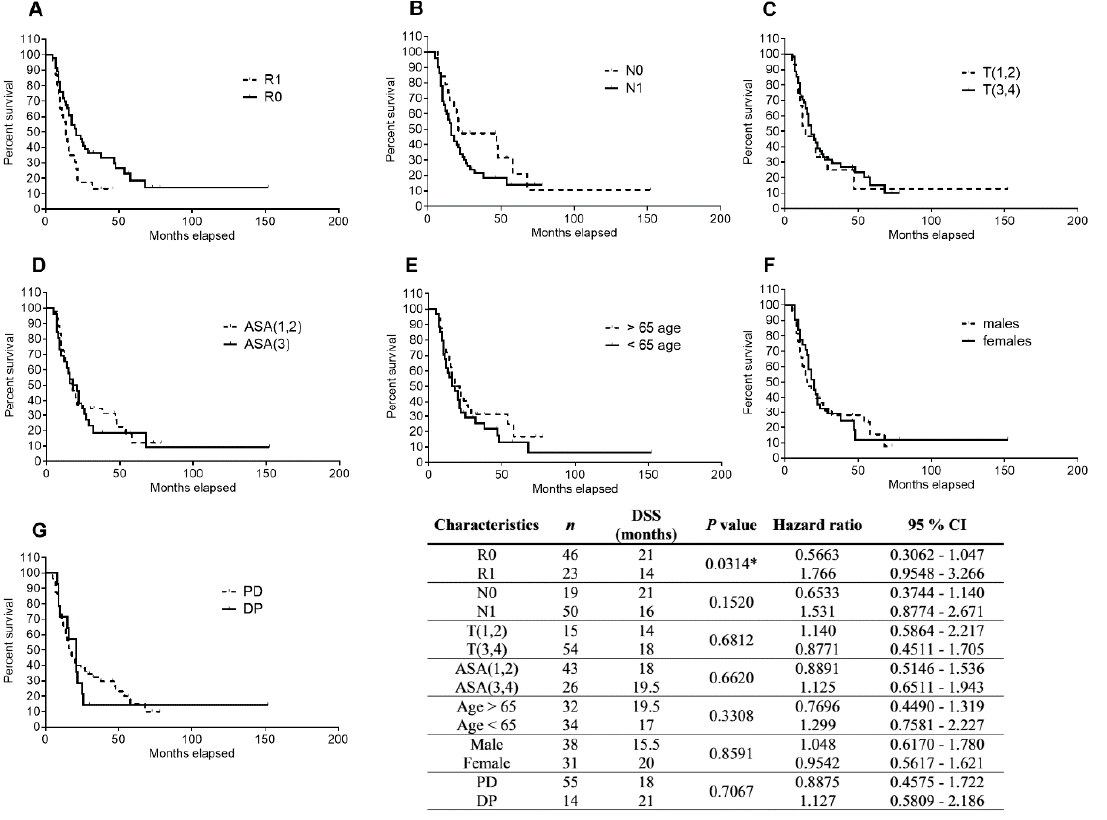
Figure 1. Analysis of patients’ DSS association with resection margin status, regional lymph node involvement, primary tumor stage, ASA score, age, gender, and type of resection using Kaplan–Meier curves. Patients ( n = 69) were dichotomized based on ( A ) tumor border (R0 / R1), ( B ) negative / positive regional lymph nodes (N0 / N1), ( C ) primary tumor stage T(1,2) / T(3,4), ( D ) ASA score ASA(1,2) / ASA(3,4), ( E ) patients’ age ( > 65 age /< 65 age), ( F ) gender, and ( G ) type of resection (PD / DP). The data were analyzed using the log rank test. Statistical significance is denoted by *, p < 0.05.